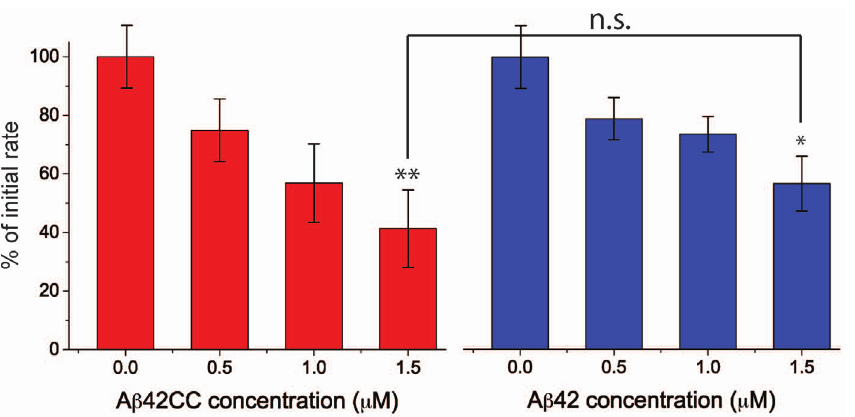
Figure 7. Effect of A b 42 CC protofibrils (red) and wild type A b 42 oligomers (blue) on spontaneous synaptic activity in mouse primary hippocampal neurons grown on a multielectrode array (MEA) chip. Changes in firing rates are normalized to the initial electrical activity in the absence of treatment and compared to buffer-treated neurons: ** – p , 0.0015, * – p , 0.026 (Student’s t-test); the difference between A b 42 oligomers and A b 42 CC protofibrils is not